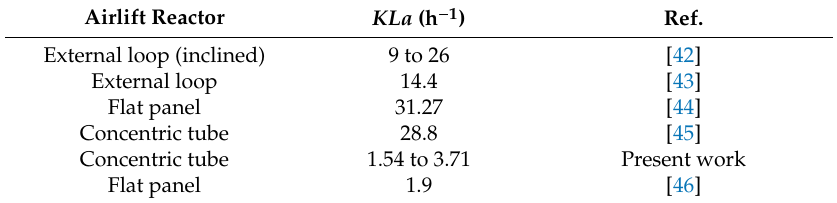
Table 6. Comparison of volumetric mass coefficients among different Airlift configurations. Airlift Reactor KLa (h − 1 ) Ref. 9 to 26